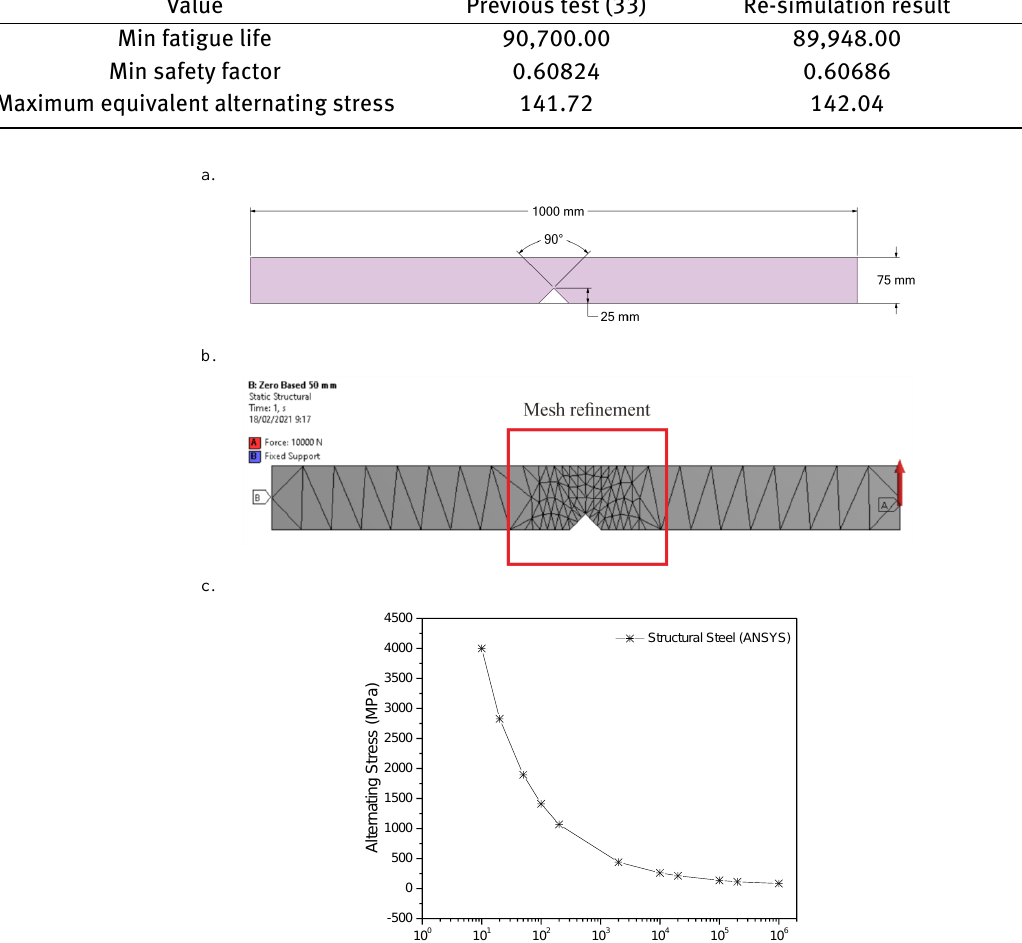
are intended for a minimum cycle life of 10 6 . Their one end is stationary, whereas the other end is loaded with a force of 10 kN in the direction of the z-axis (Figure 8b).